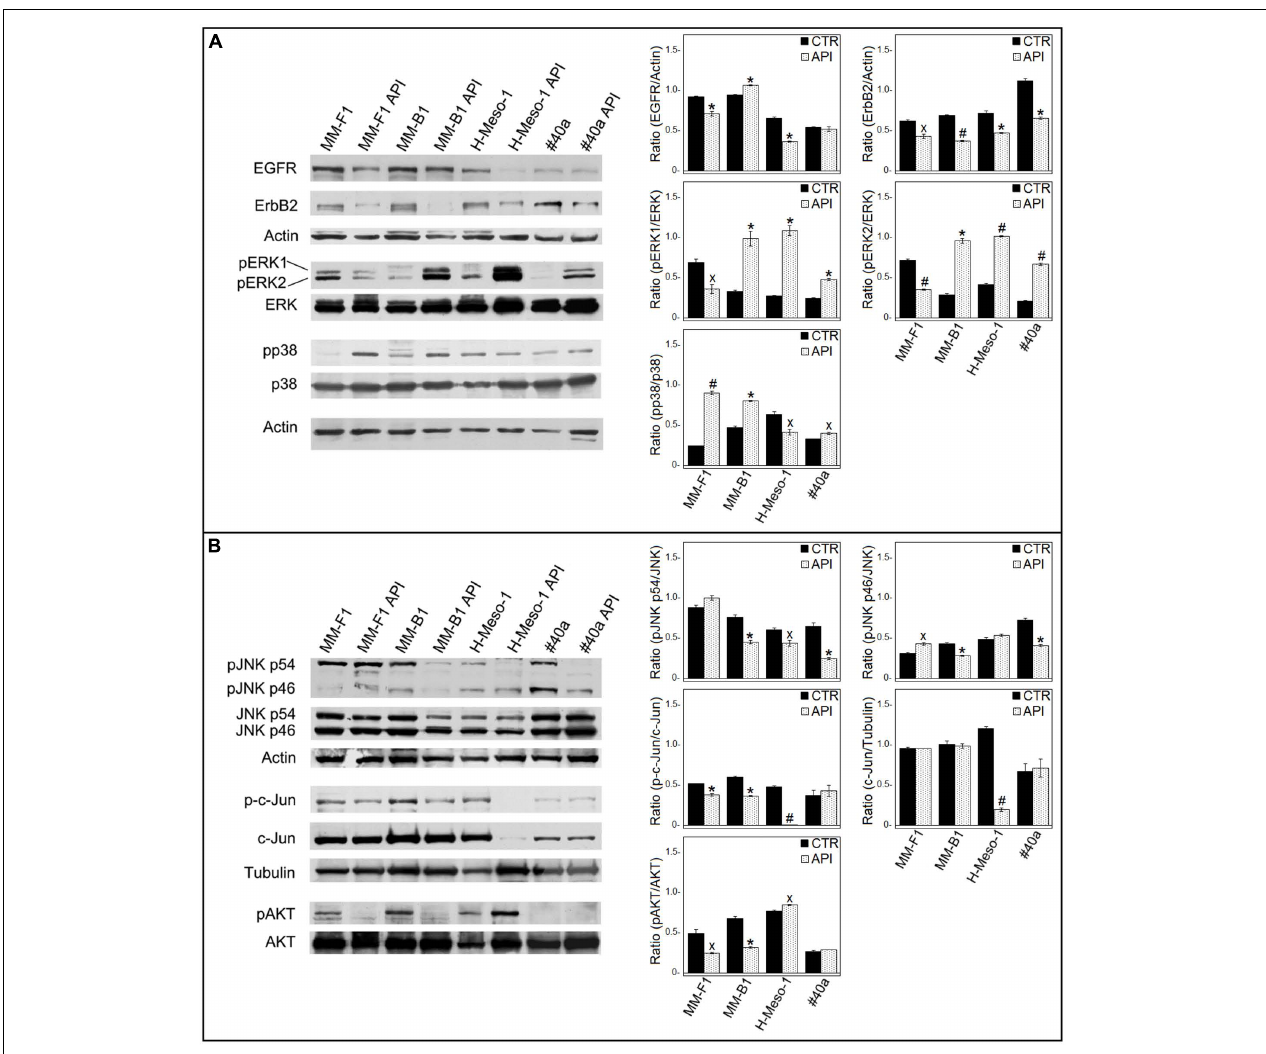
FIGURE 8 | Effect of API on the expression and activation of signaling pathway molecules. Western blotting analysis was performed on MM cells treated with API (50 µ M) or DMSO (CTR) for 24 h. (A) The levels of pERK1 and pERK2 proteins, as well as p-p38 protein were compared with that of total ERK and p38 proteins, respectively. (B) The levels of pJNK p54, pJNK p46, p-c-Jun, and pAKT were compared with that of total JNK, c-Jun and AKT proteins, respectively. The ratios and statistical analysis are reported. Data are expressed as the mean ± SD of two independent experiments ( x p ≤ 0.05, ∗ p ≤ 0.01, # p ≤ 0.001 compared with CTR). Actin and tubulin were used as an internal